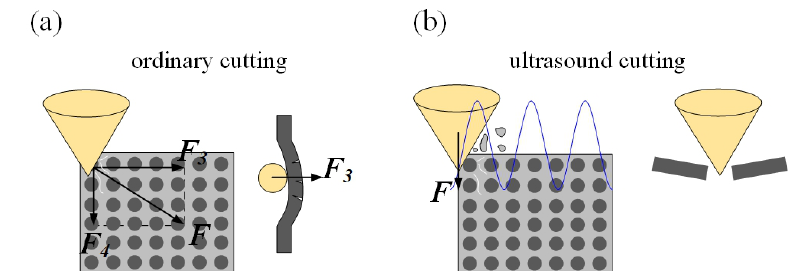
Figure 10. Comparison of material removal mechanisms between ordinary cutting and ultrasound cutting when the fiber orientation angle is 90 ◦ . ( a ) is ordinary cutting and ( b ) is ultrasound cutting.